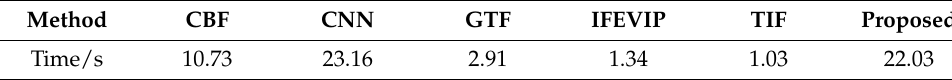
Table 3. Computational efficiency of different